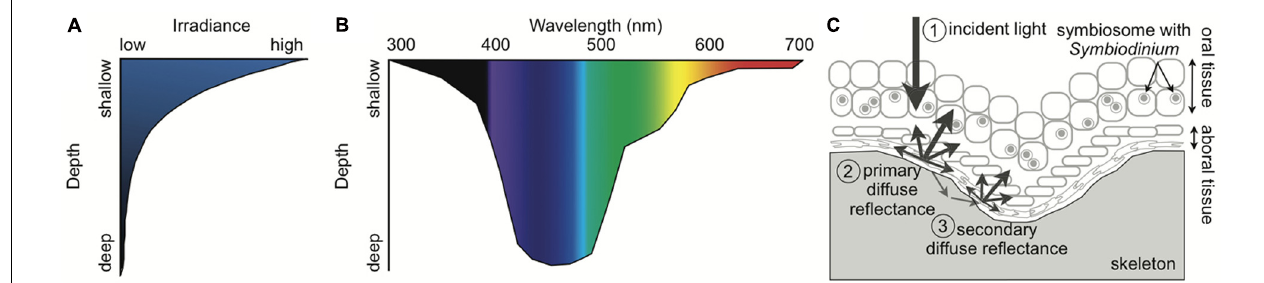
FIGURE 2 | Schematic of the light environment of the coral–algal symbiosis. (A) Irradiance rapidly declines with depth in the ocean. (B) Light spectrum narrows with depth, becoming primarily blue.Wavelength attenuation properties and absorption by inorganic and organic matter in the water column determine the spectral composition at depth. (C) Fundamental light dynamics in the coral–algal symbiosis. (1)The principal light is downwelling incident sunlight. If the incident light is not absorbed by the coral